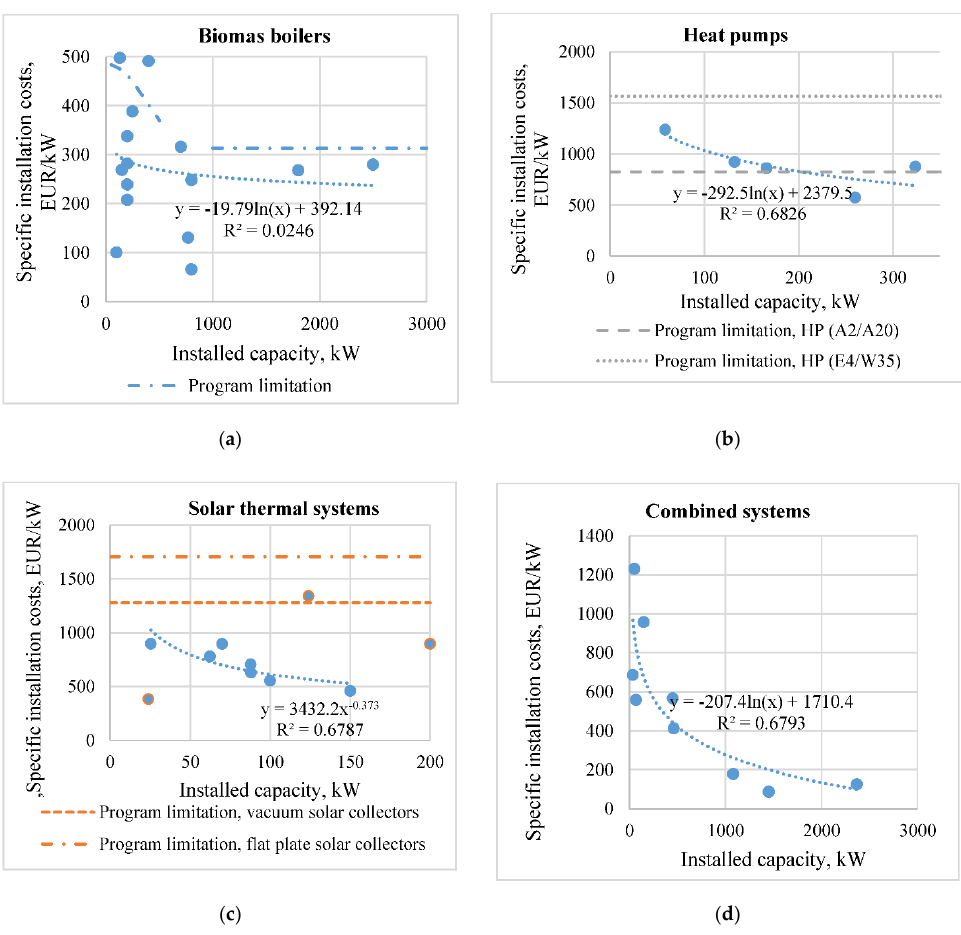
Figure 3. Regression analyses and the set specific cost limits of the program for different RES technologies: ( a ) biomass boilers; ( b ) heat pumps; ( c ) solar thermal systems and ( d ) combined systems